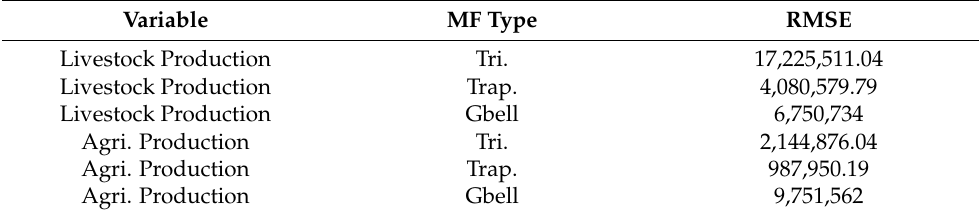
Table 3. RMSE results for ANFIS models with different MF types in the training